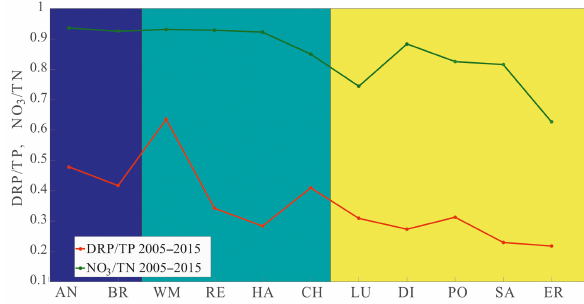
Figure 2. Ratios of DRP / TP (red) and NO 3 / TN (green) across catchments computed on the period 2005–2015. Both patterns show a decreasing trend from more to less anthropogenically affected catchments (left to right of x axes). This pattern is more evident for phosphorus. Background colors refer to the catchment classification explained in Sect.